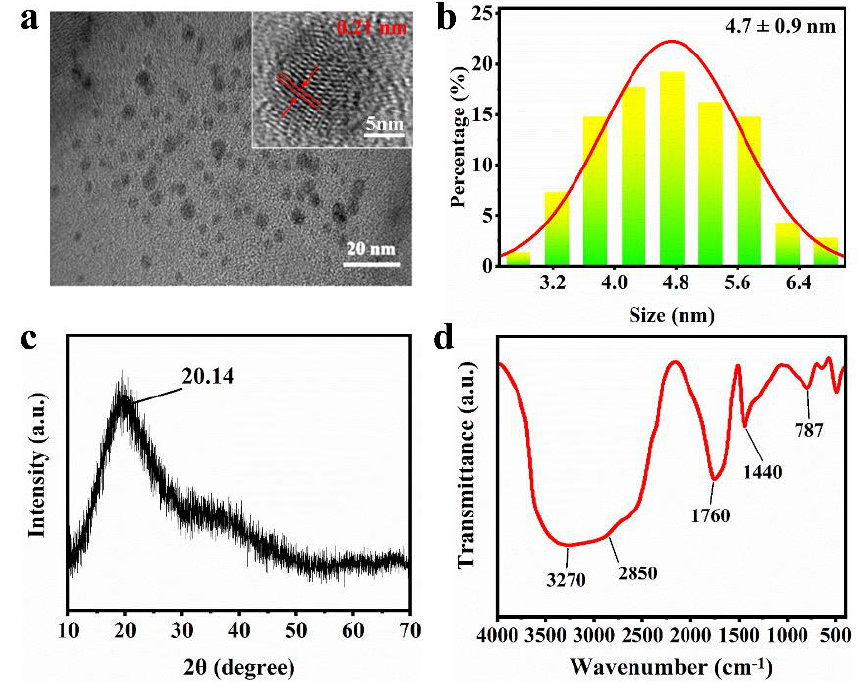
Figure 2. ( a ) HRTEM image, ( b ) Size distribution, ( c ) XRD pattern, and ( d ) FT − IR spectrum of AA- CPDs.